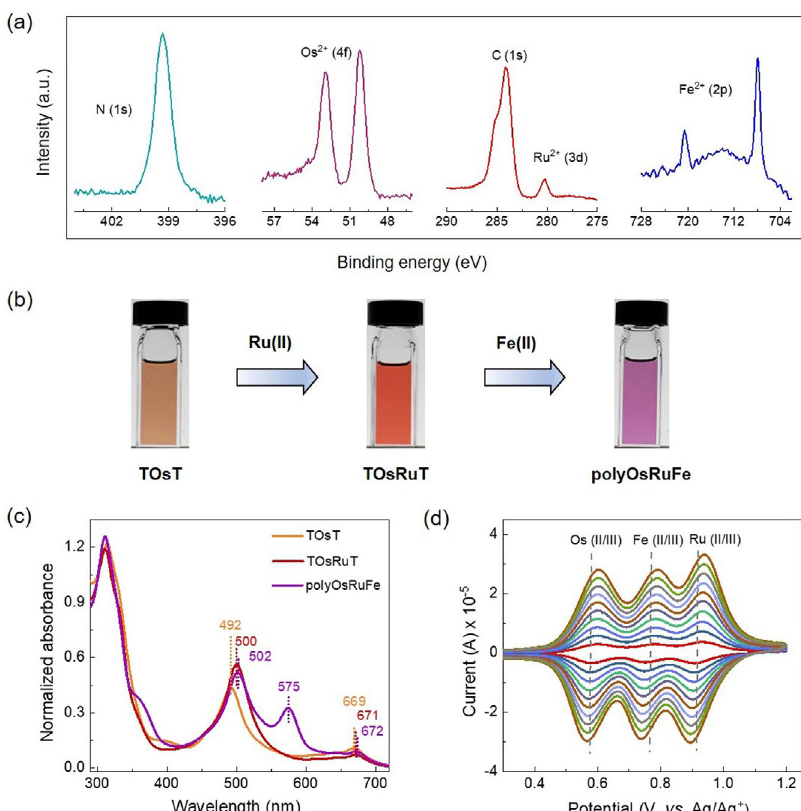
Fig. 4 XPS, UV – vis, and CV analysis of polyOsRuFe. a Normalized X-ray photoelectron spectrum of polyOsRuFe showing N (1s), Os 2 + (4f), Ru 2 + (3d), and Fe 2 + (2p) bands. b Change in color in the solution state upon the stepwise complexation of Os(II) in TOsT, followed by Ru(II) in TOsRuT and Fe(II) in polyOsRuFe. c UV – vis spectra of TOsT, TOsRuT (both solutions were 5 × 10 − 6 M in CH 2 Cl 2 /CH 3 OH; 1/1, v/v), and polyOsRuFe (5 × 10 − 6 M in DMSO). d Cyclic voltammograms of polyOsRuFe at scan rates of 0.01 – 0.1 V/s in a three-electrode system, electrolyte: 0.1 M LiClO 4 in CH 3